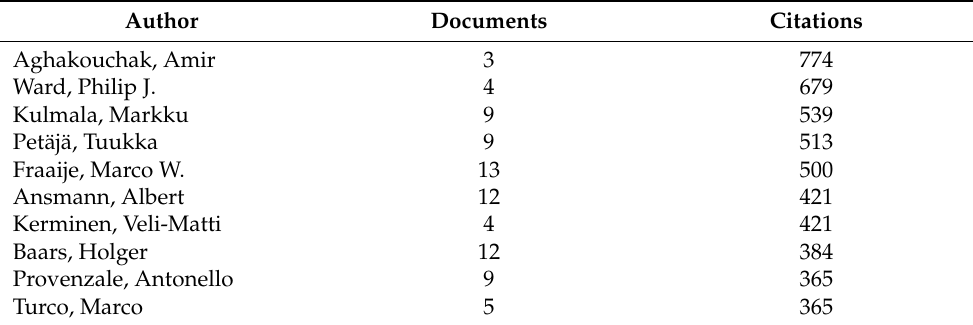
Table 2. Top 10 most-cited